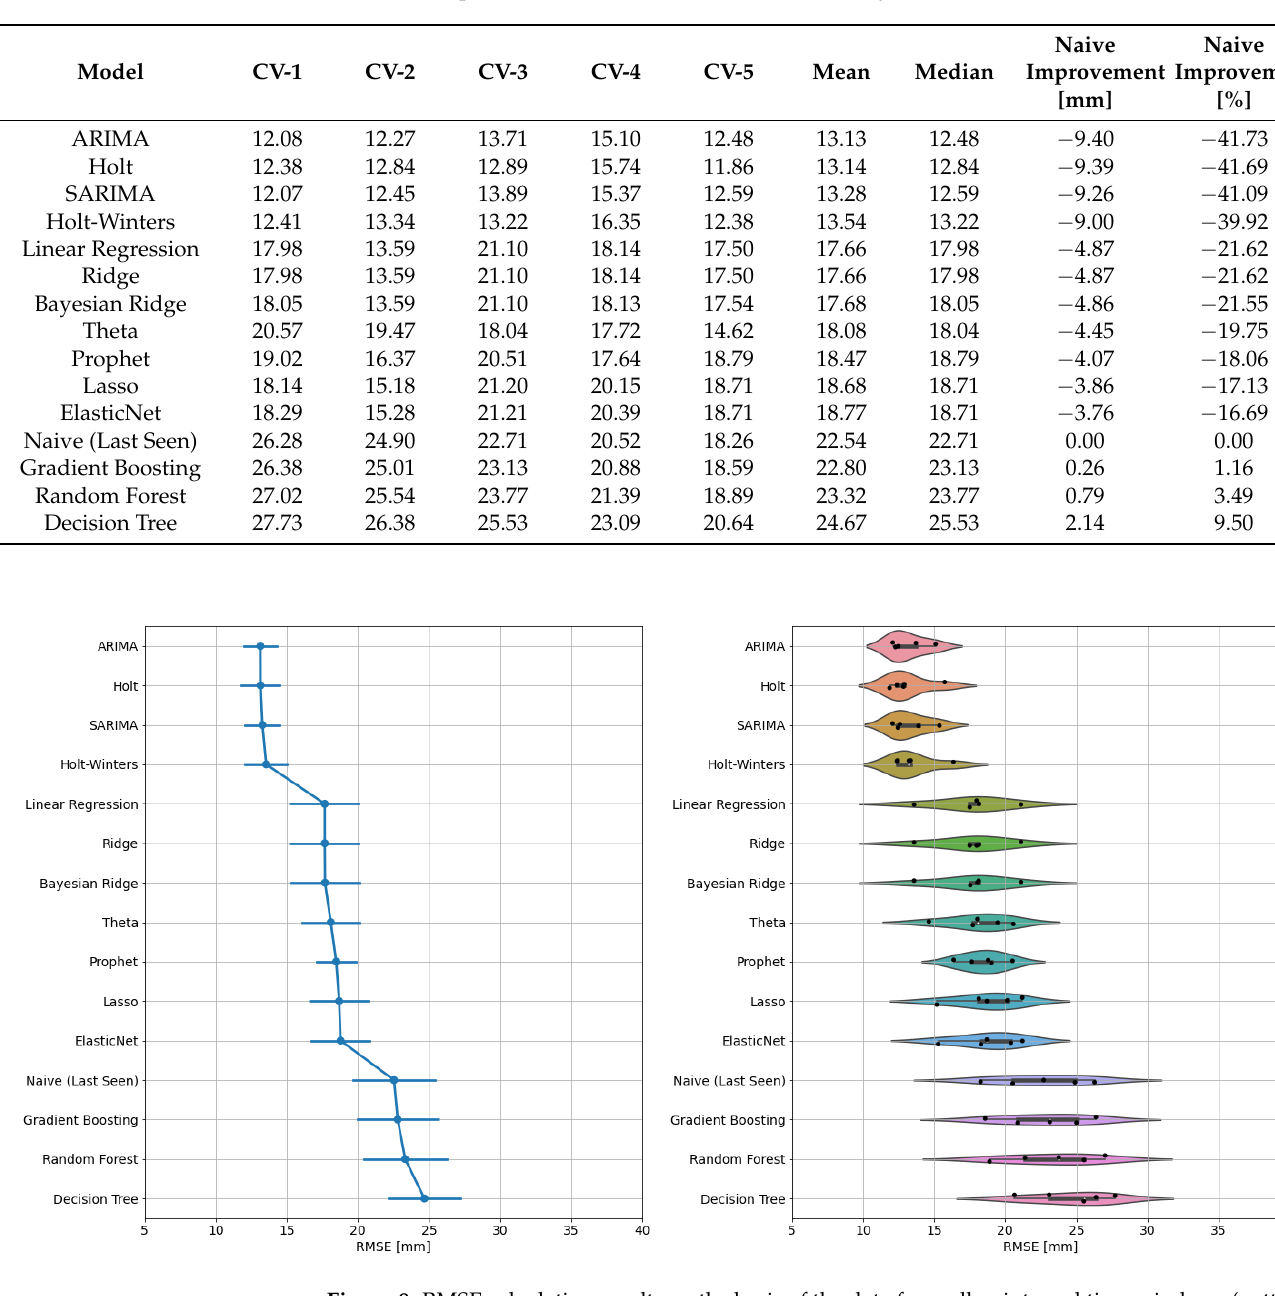
Figure 8. RMSE calculation results on the basis of the data from all points and time windows (pattern a from Figure 4). The visualization on the left shows the results as a pointplot with the mean and standard deviation values from all five cross validation groups per model. The visualization on the right shows the results as a violinplot from all five cross validation groups per model. Based on the above visualizations, the models can be classified into three groups by their performance in comparison with the Naive approach. Group with the best results includes the following models: ARIMA, Holt, SARIMA and Holt-Winters. Another group which provides results better than the Naive approach, but a worse ARIMA and Holt than group includes the following models: Linear Regression, Ridge, Theta, Prophet, Lasso and ElasticNet. The last group does not provide better results than the Naive approach and includes models based on decision trees (Gradient Boosting, Random Forest and Decision